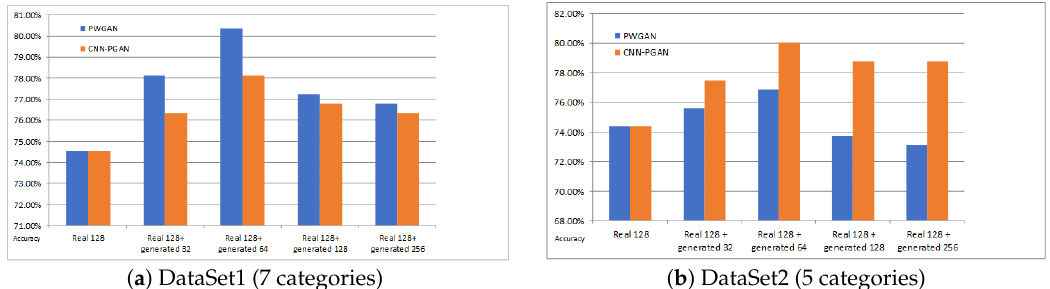
Figure 8. The accuracy for different amounts of generated data for training on DataSet1 and DataSet2. The blue bar and the yellow bar indicate the classification accuracies of PGAN and CNN-PGAN, respectively. The first column is the classification result on the real 128 training images. The second, third, fourth, and fifth columns are the results of training data augmentation using 32, 64, 128, and 256 generated images, respectively.